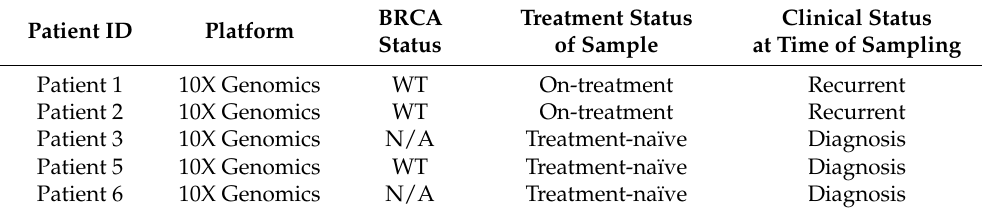
Table 1. Characteristics of patients and specimens included in this